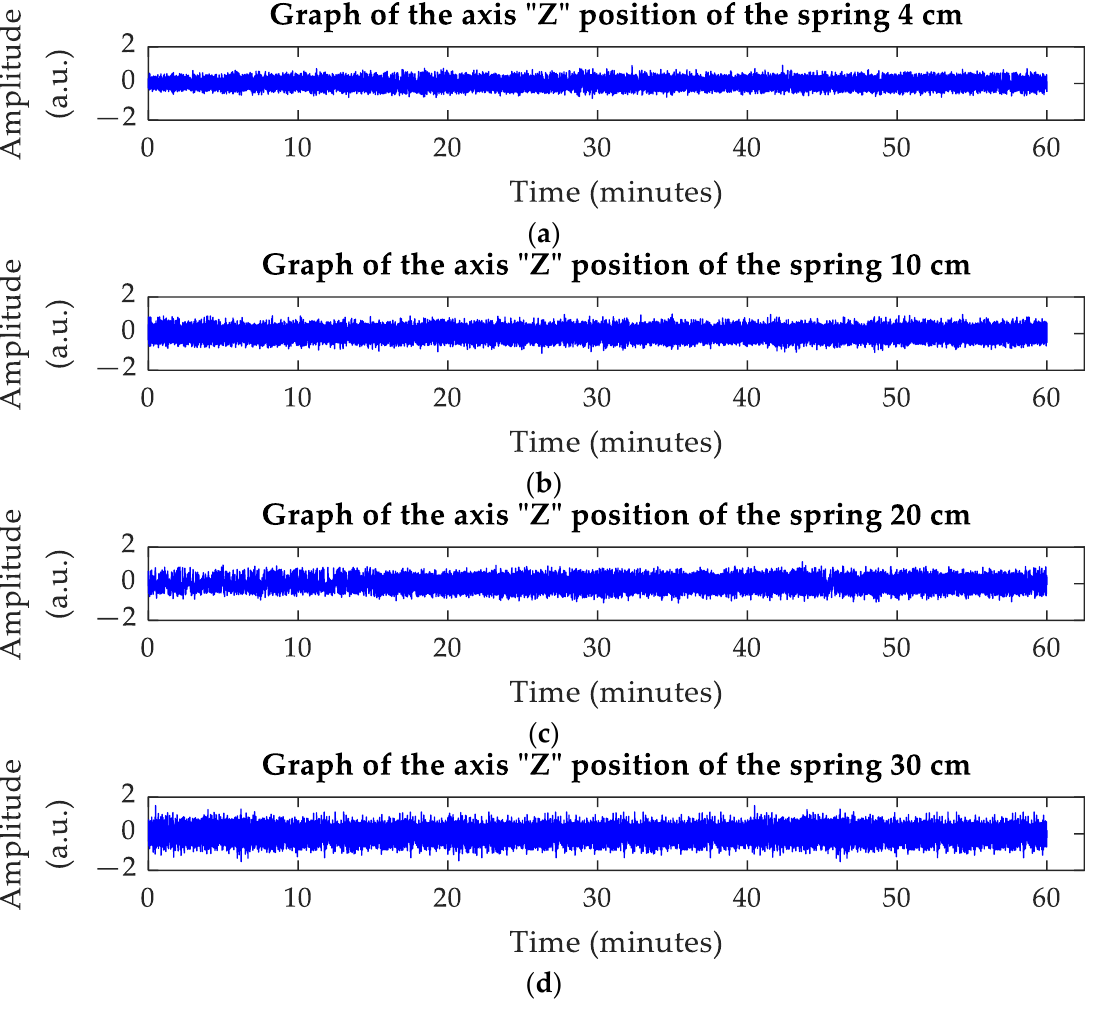
Figure 5. ( a ) ratio between amplitude of the "Z" axis and time in seconds at spring position 4 cm, a.u. (arbitrary units); ( b ) ratio between amplitude of the "Z" axis and time in seconds at spring posi- tion 10 cm, a.u (arbitrary units); ( c ) ratio between amplitude of the "Z" axis and time in seconds at spring position 20 cm, a.u. (arbitrary units); ( d ) ratio between amplitude of the "Z" axis and time in seconds at spring position 30 cm, a.u.(arbitrary units).